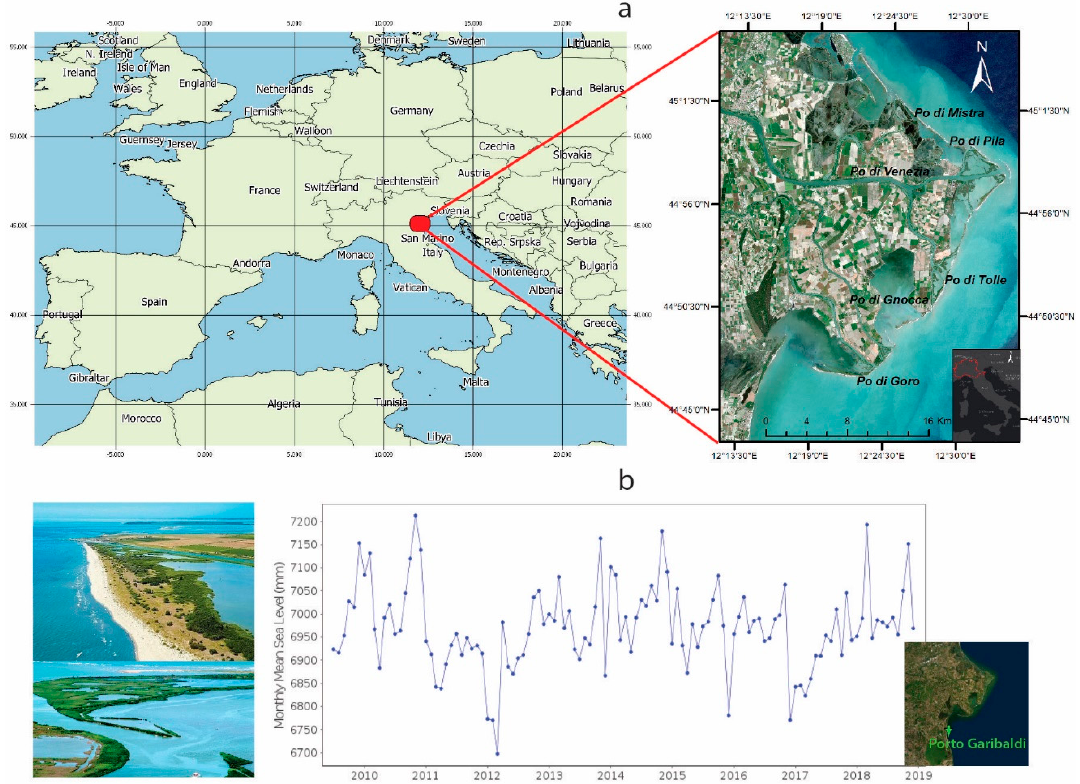
Figure 1. ( a ) Po Delta study area; ( b ) monthly mean sea level at Porto Garibaldi, lat. 44.678–lon. 12.249, between 2010 and 2019 [68,69].